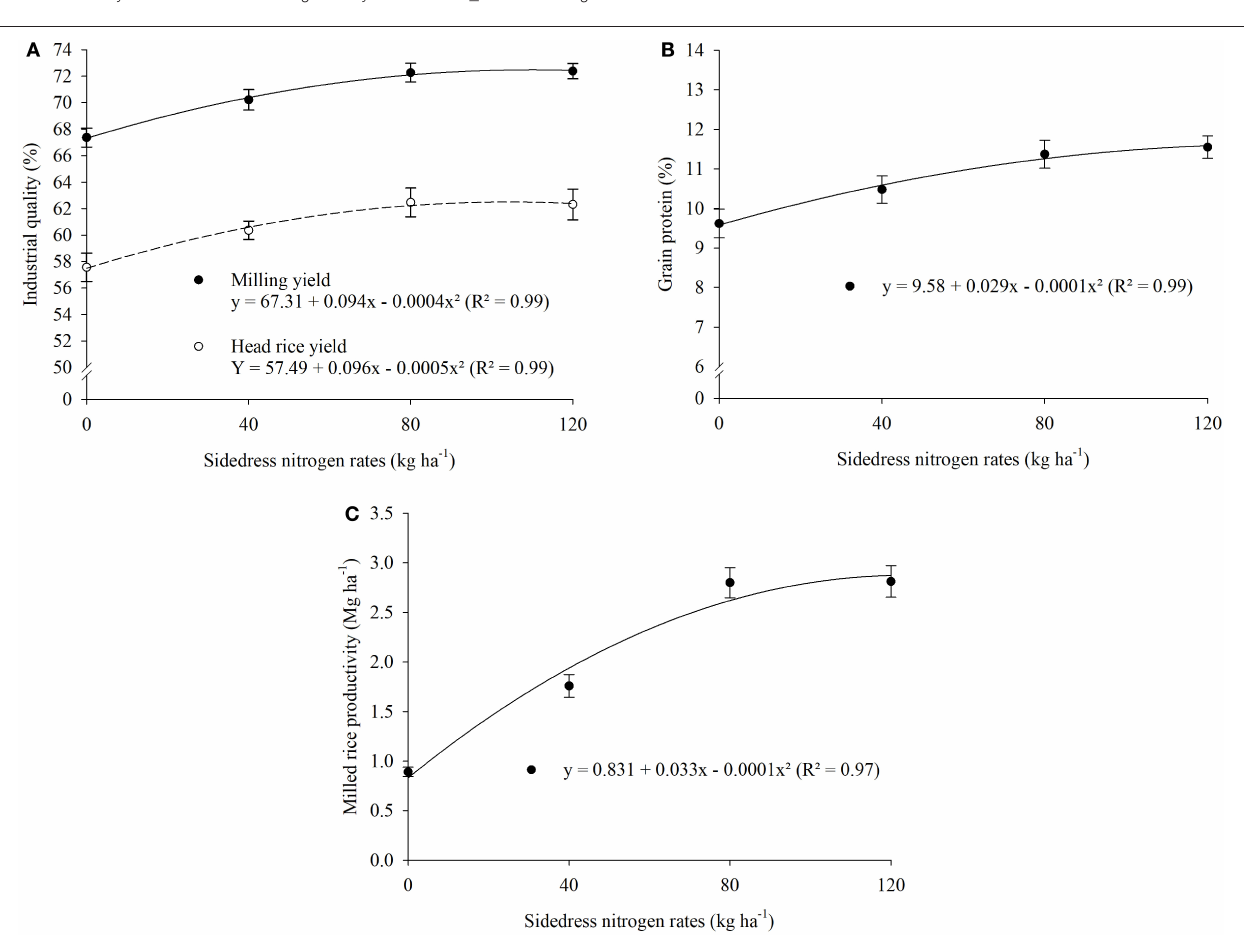
FIGURE 3 | Industrial quality (A) , grain protein (B) , and milled rice productivity (C) as affected by sidedress nitrogen rate. Each data point is the mean of 36 replicates (three cropping systems, four blocks, and three growing seasons) and associated error bar is ± one SE.